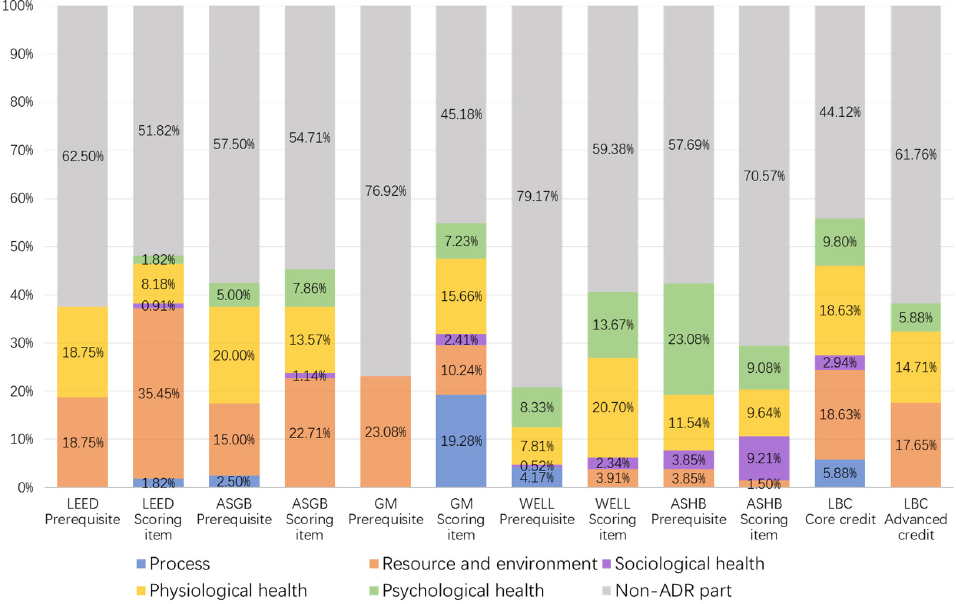
Figure 2. RSI comparison of TEF’s five sections in prerequisites and scoring items of six GBRSs. (Source: by the author).